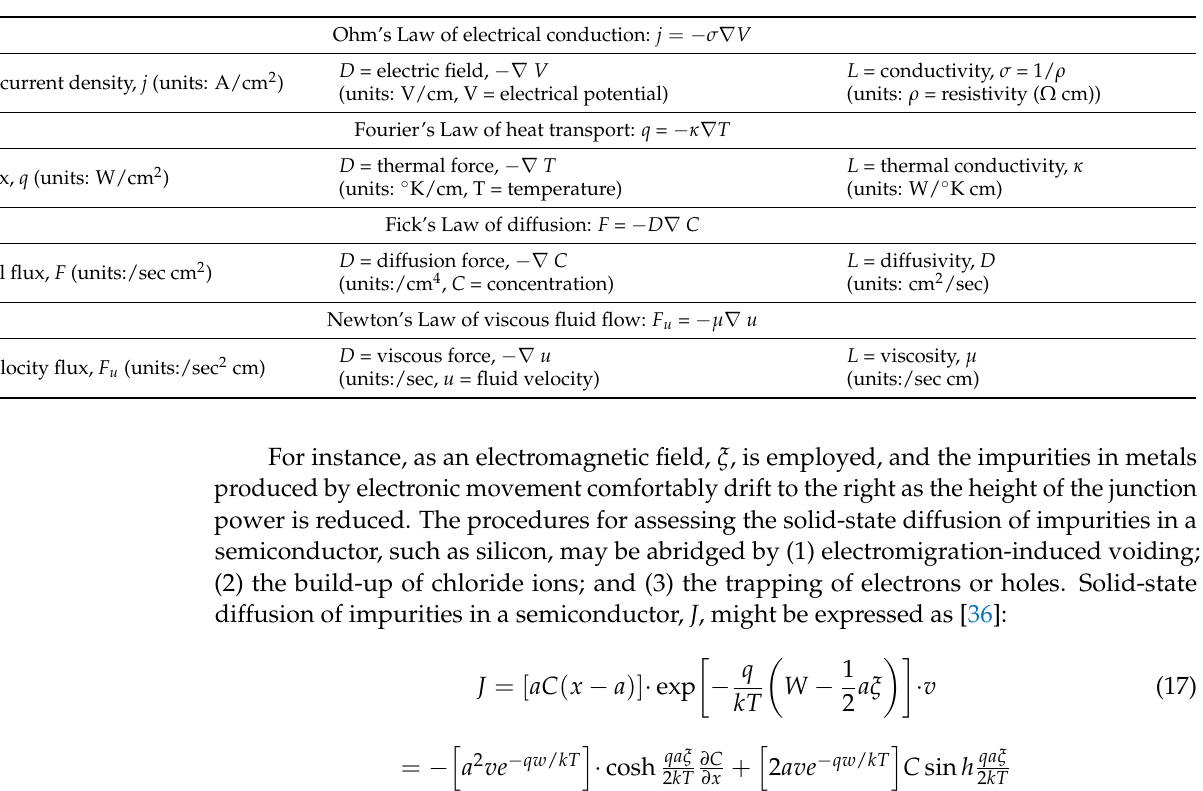
Table 2. Power stated as effort and flow in an energy transport